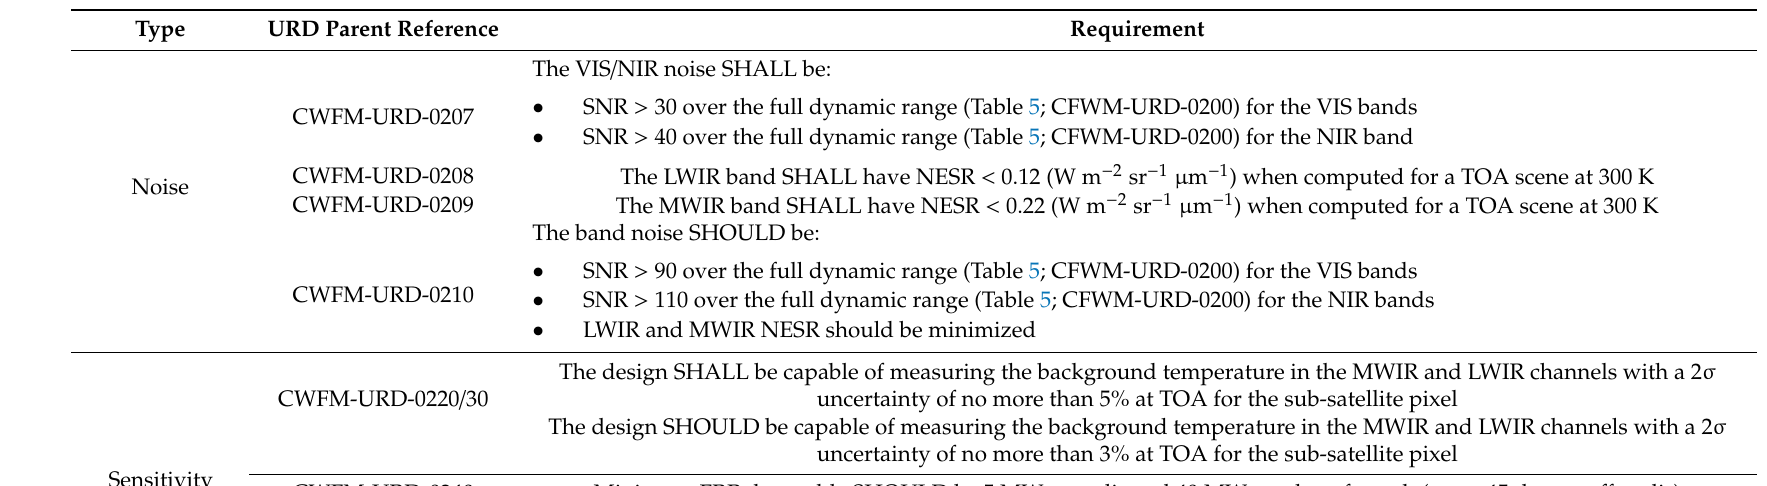
Table 6. Summary of key Precision Requirements as outlined in the User Requirements Document (URD), and refined in the Mission Requirements for WildFireSat. SNR refers to the Signal to Noise Ratio, NESR refers to the Noise Equivalent Spectral Radiance, and TOA refers to Top of